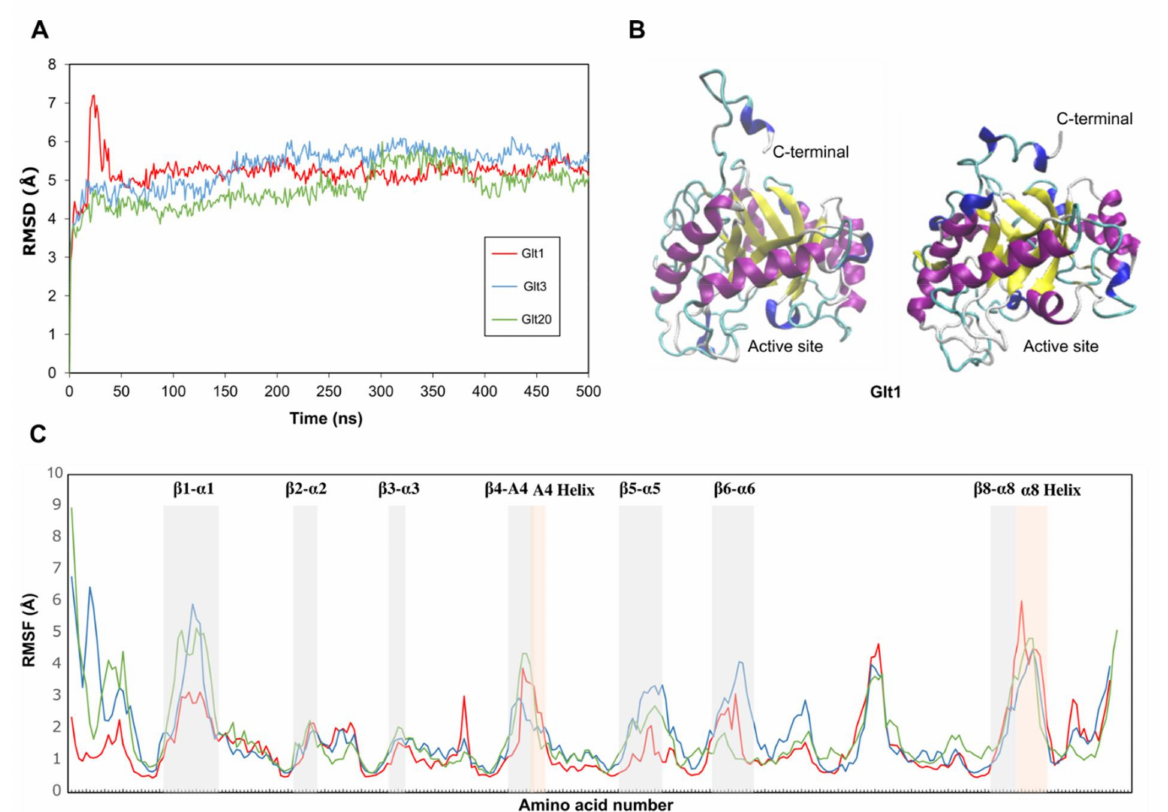
Figure 4. Molecular dynamic simulations of Glt1, Glt3 and Glt20. ( A ) Root-mean-square deviation (RMSD) of alpha carbons. The peak observed the first 38 ns in Glt1 corresponds to a conformational change in a C-terminal loop. ( B ) Conformational change in the C-terminal loop of Glt1. ( C ) Root-mean-square fluctuations (RMSF). Peaks corresponding to loops surrounding the active site are indicated in gray, while the helixes in